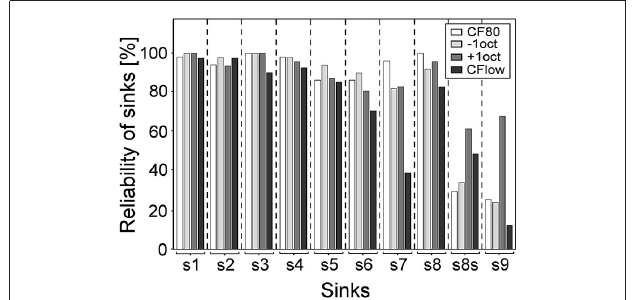
FIGURE 5 | Reliability of sinks. Bars give the percentage of presence of sinks for the different stimuli. Sinks s1–s4 and s8 were present in most of the laminar profiles (mean = 96%). Sink s7 of CF24+ was absent in 61% of profiles. The maximum activity of s8 (s8s) elicited by +1oct and CF24+ was located in 62 and 49% of laminar profiles above the layer III/IV border. The sink s9 of +1oct was present in 68% of the laminar